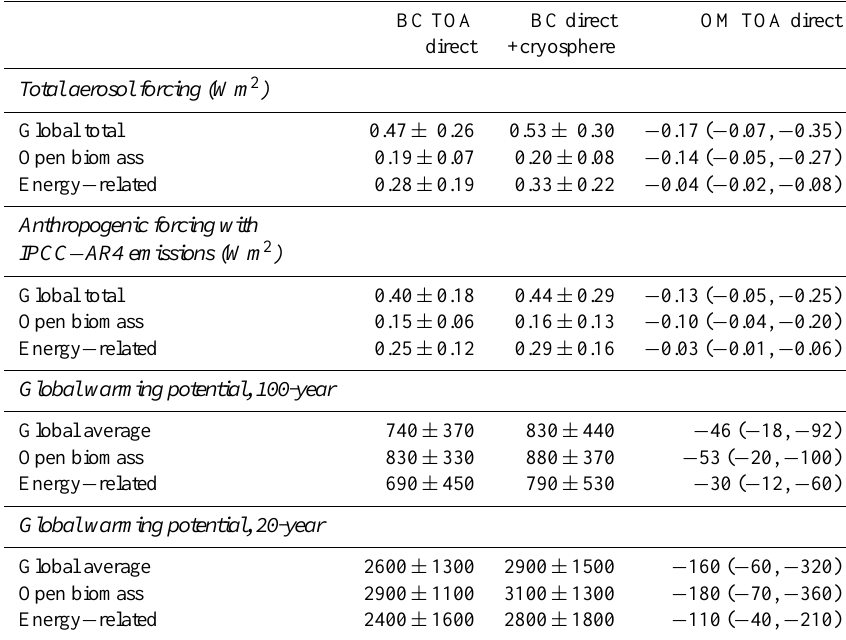
Table 2. Global average forcing and global warming potentials derived from SFP combined with estimates of emissions (aerosol and anthropogenic forcing) or carbon dioxide forcing (global warming potentials). Uncertainties for OM are asymmetric and are presented as